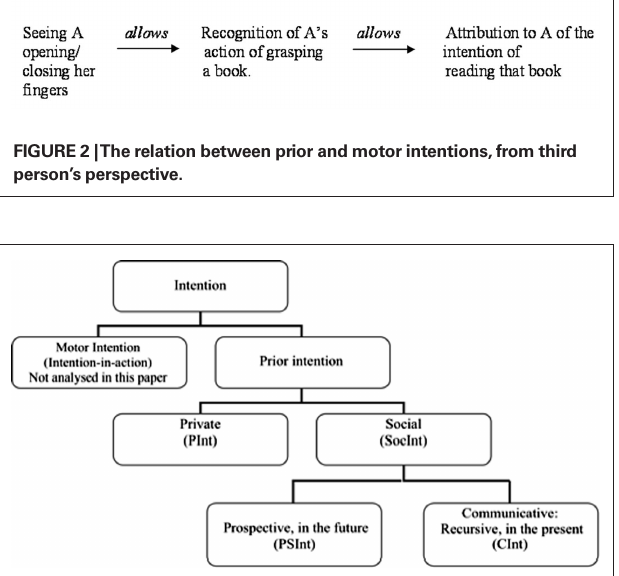
FIguRe 3 | Classification of the different types of prior